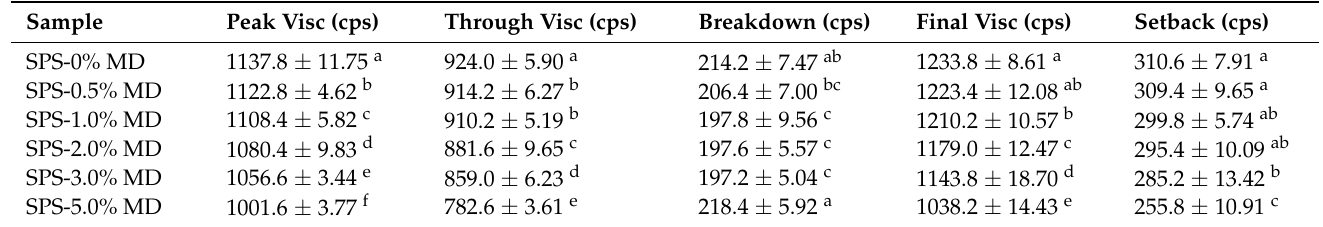
Figure 2. The pasting curves ( A ) and DSC patterns ( B ) of sweet potato starch (SPS) noodles with vari- ous (0, 0.5, 1, 2, 3, and 5%, w / w ) maltodextrin (MD) concentrations. Inset: the enlarged endothermic peak of each sample. Table 2. Pasting property of sweet potato starch (SPS) with various (0, 0.5, 1, 2, 3, and 5%, w/w ) maltodextrin (MD)